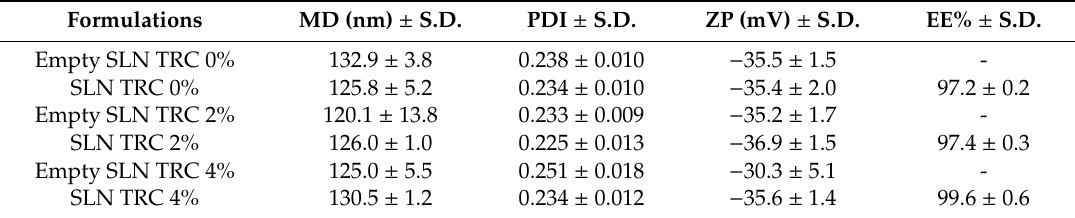
Table 2. Mean diameter (MD), polydispersity index (PDI), zeta potential (ZP), and % entrapment efficiency (EE%) observed for freshly prepared 8-MOP-loaded and -unloaded SLNs using different amounts of Transcutol ® P. Mean values ± standard deviation, obtained from at least 3 independent samples, were reported.